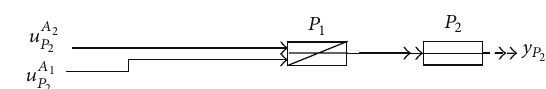
Figure 12: Synthesized two departing air traffic